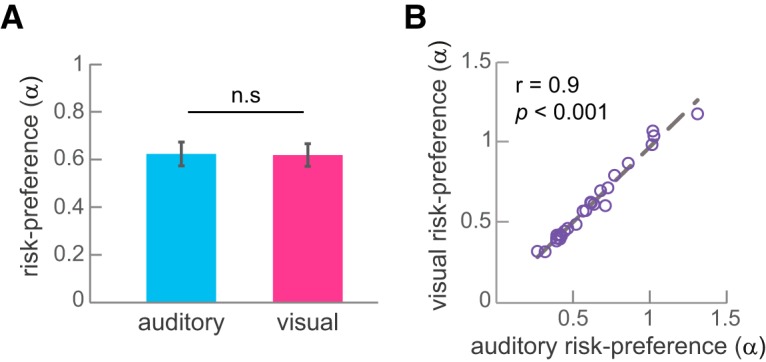
Risk preferences across sensory modalities; n = 26. A, Mean estimated risk-preference across subjects (α-parameter). Error bars indicate SEM. B, Within-subject Spearman’s correlation between the estimated risk preference parameter in the auditory and visual conditions. Each circle represents a subject.